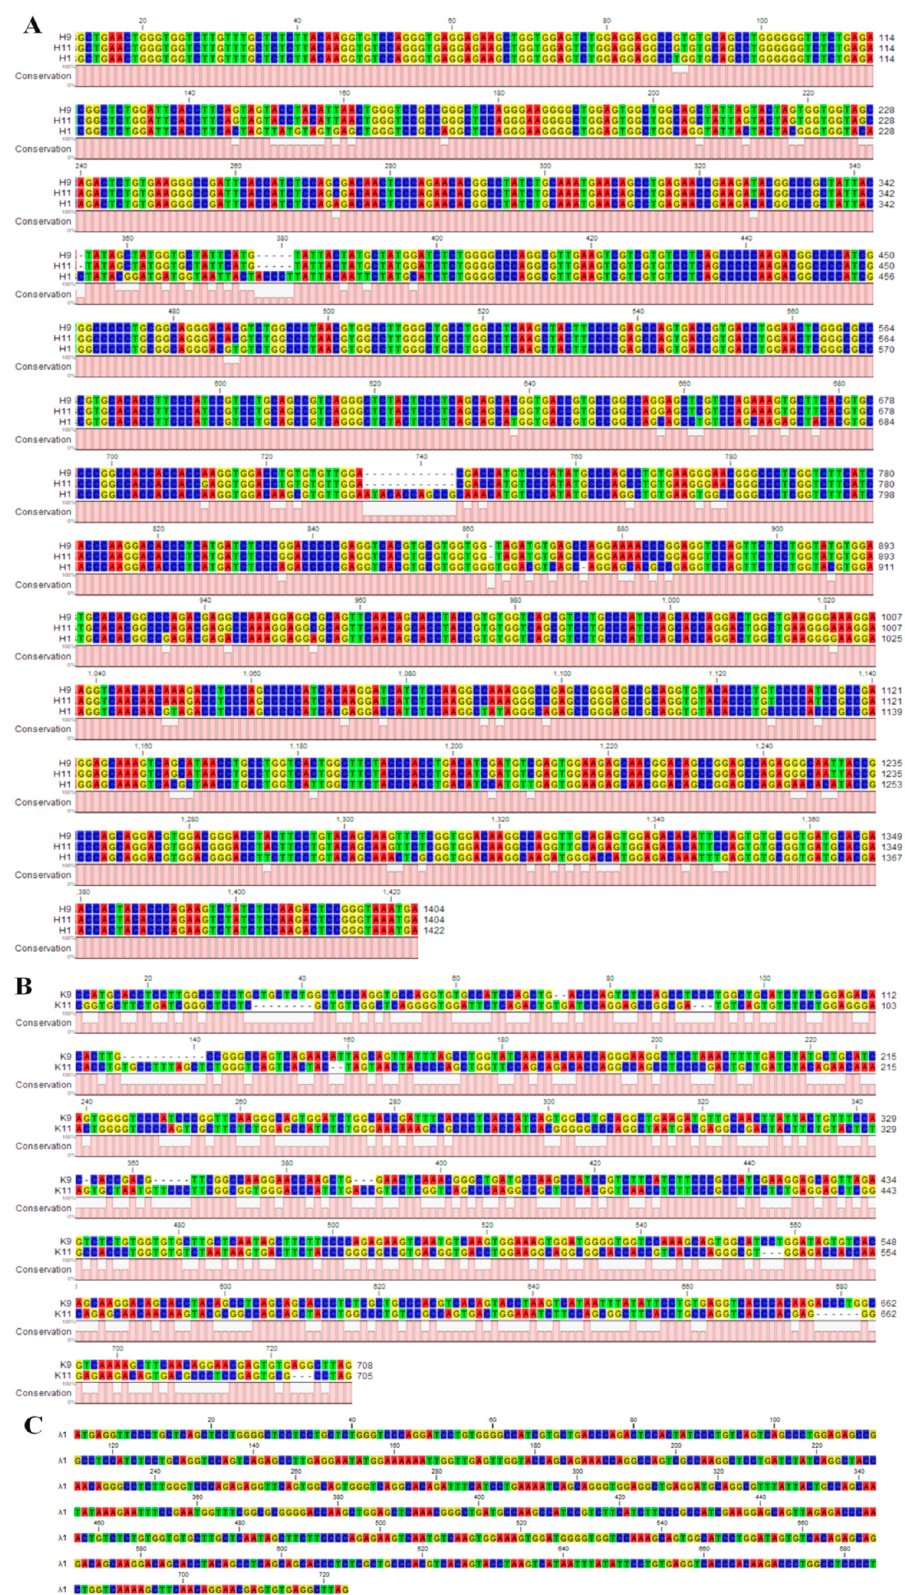
Figure 3. Sequence and sequence alignment of the paired chains from CE2 + IgG + porcine single B cells. ( A ) Sequence and sequence alignment of H1, H9 and H11. ( B ) Sequence and sequence alignment of L chains κ 9 and κ 11. ( C ) Sequence of L chain λ 1.